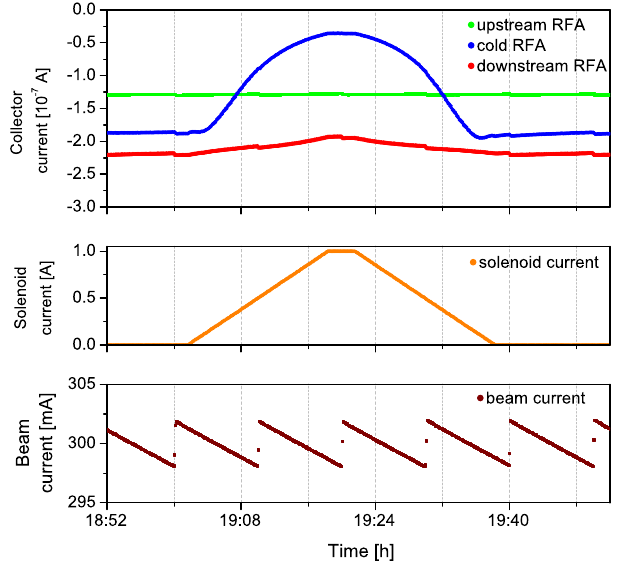
FIG. 17. Influence of the axial magnetic field produced by the solenoid on the particle flux. The collector is positively biased with þ 50